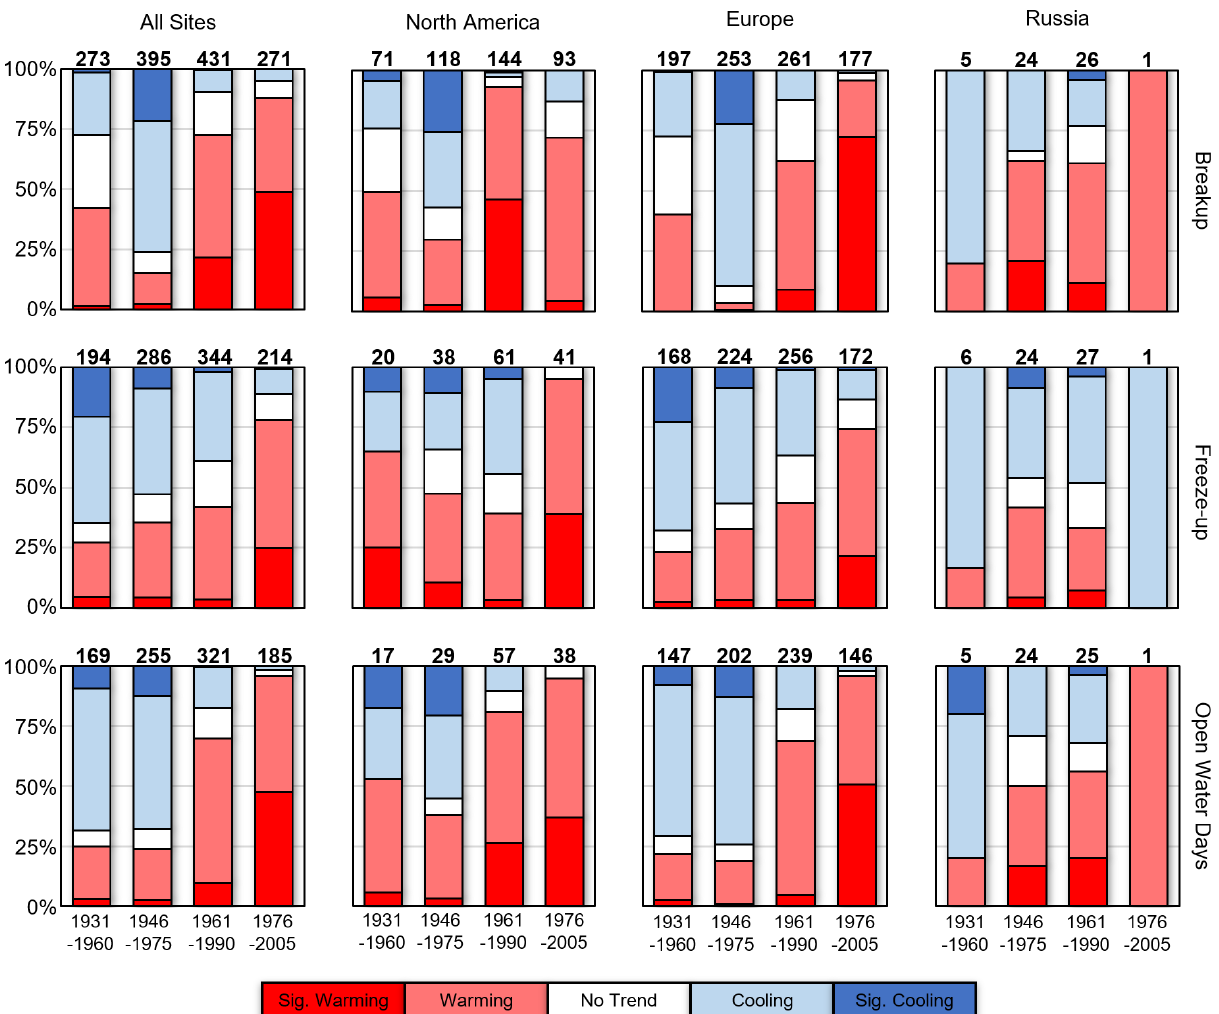
Figure 3. Summary charts showing generalised trends for all the sites contained within each of the 30-year time periods. The percentages are calculated as a proportion of the total number of sites for each time period (bold text – e.g. in the first panel, across all sites there are 273 sites with 1931–1960 breakup data). The trends are derived from the Mann–Kendall analysis for each site, where the direction and statistical significance ( α < 0 . 1) are recorded as a warming, a cooling, or no trend. A warming trend for breakup or freeze-up dates is determined by a negative (earlier date) or positive (later date) trend, respectively. A cooling trend for breakup or freeze-up dates displays a positive (later date) or negative (earlier date) trend, respectively. For the number of annual open-water days a positive Mann–Kendall value indicates an increase. Sig. Warming/Cooling in the key indicates sites where that trend was statistically